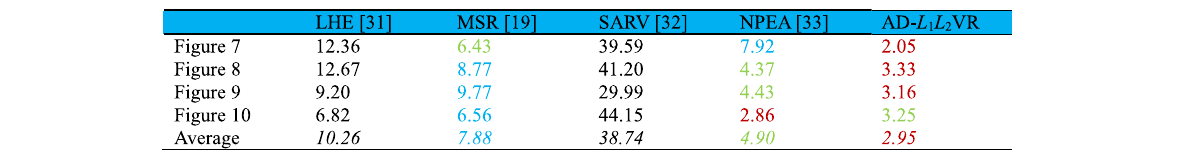
italics values are the average values that can evluate the performance of different methods more accurately. red color data represents the highest value, green color data represents the second highest, and blue color data represents the third